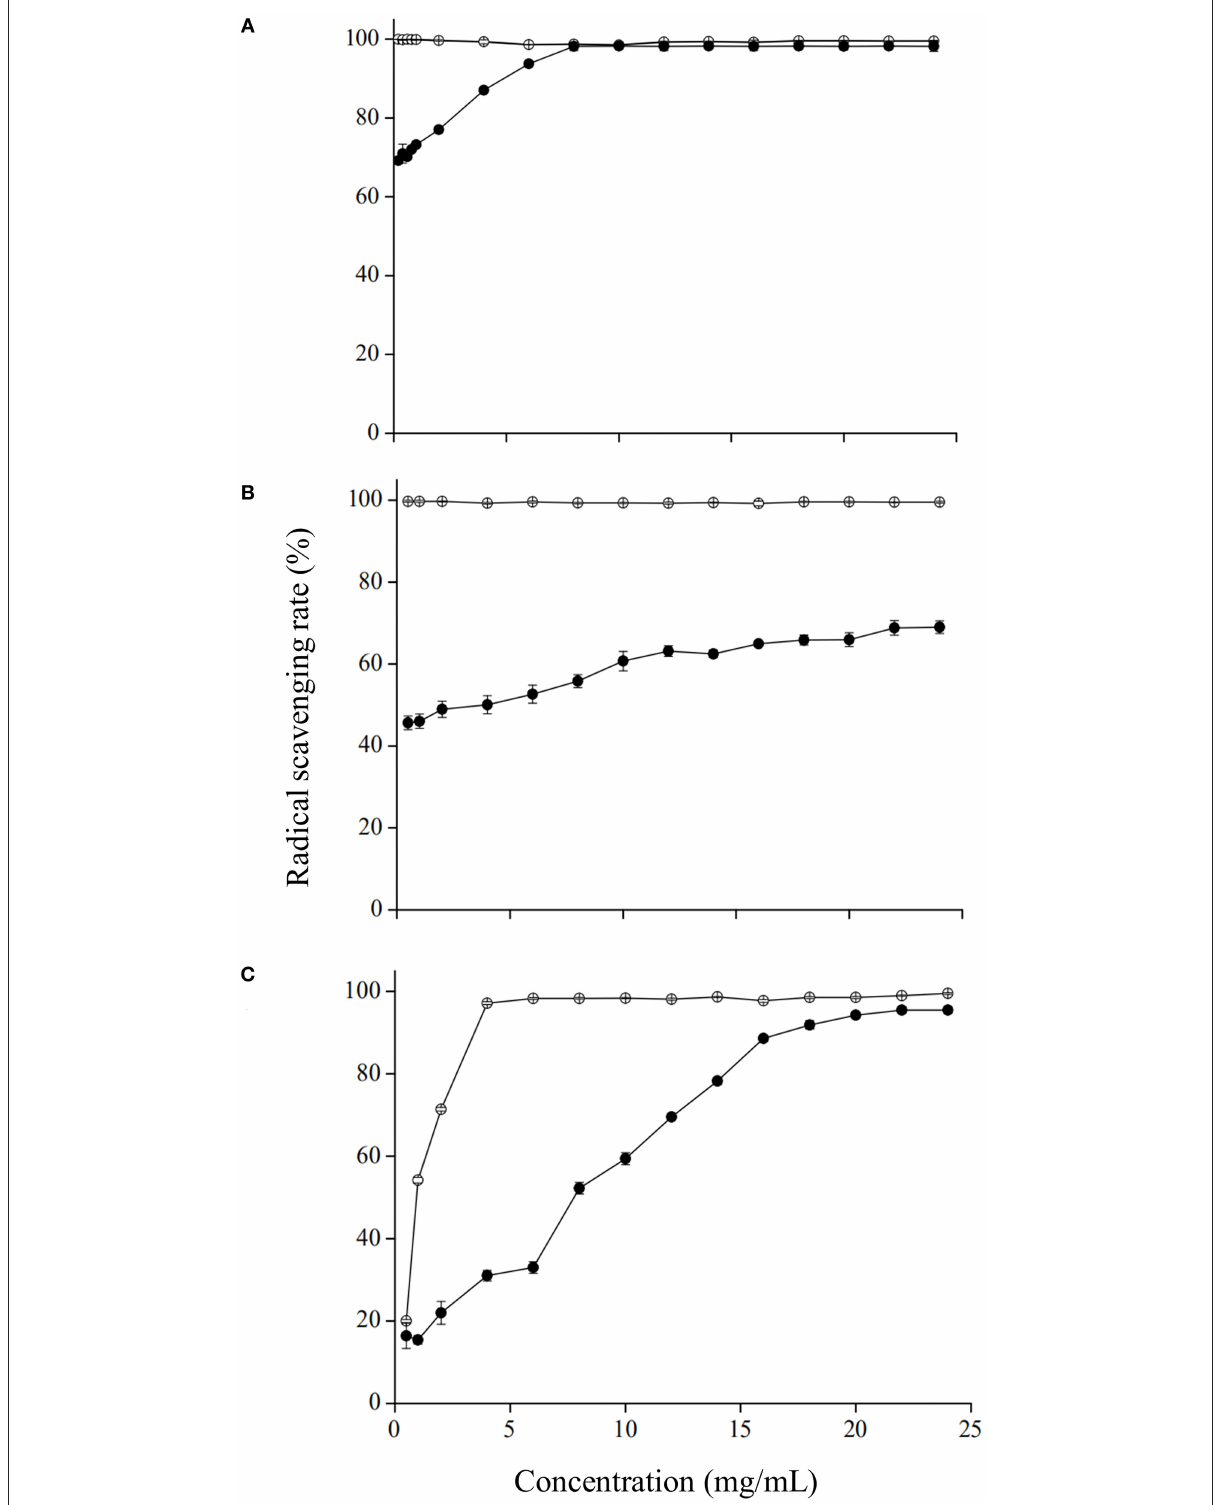
FIGURE3 Antioxidant capacities of GRP to DPPH • (A) , ABTS • + (B) , and OH • (C) . Ascorbic acid (open circles) was used as the standard for all the three assays. Data were calculated as the radical scavenging rate (%). Results were presented as mean ± SD of three independent experiments ( n = 3). GRP, ginsenosides-extracting residue